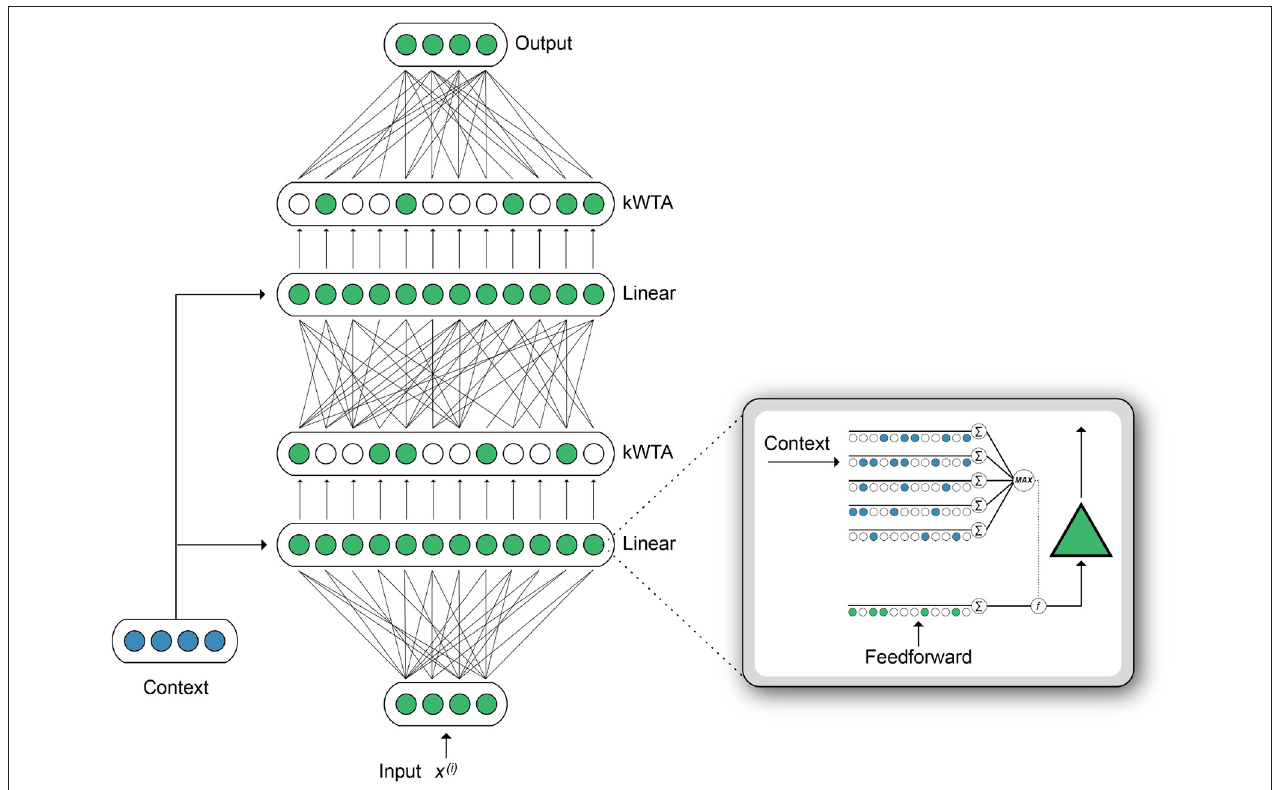
FIGURE 2 | [Right (inset)] Illustration of a single Active Dendrites Neuron. Feedforward weights (green) receive regular feedforward input while dendritic segments (blue) receive a context vector. After all dendritic segments compute an activation value, the highest value modifies the linear weighted sum computed by feedforward weights. (Left) An overview of the base network structure used in our experiments. There are two hidden layers. Each layer outputs sparse activations, as determined by a k WTA activation function. In addition, the weights between layers can be sparse. A context vector is computed for each input. The dendritic segments in each layer receive this context vector as